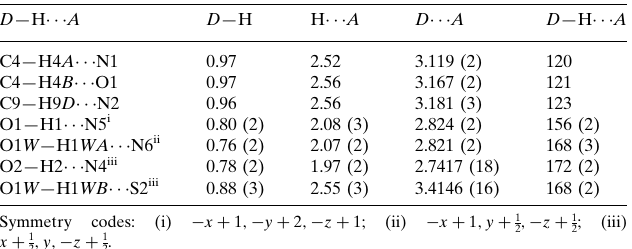
Hydrogen-bond geometry (A˚ , (cid:4)